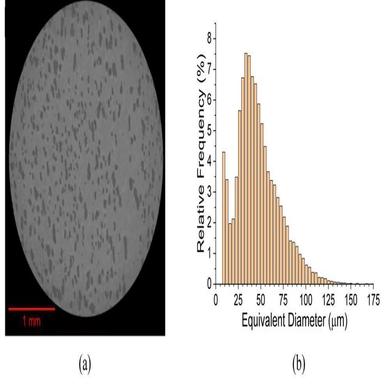
(a) X-CT image of FDE-AM sample (b) Relative frequency distribution as a function of equivalent diameter of void. EFD-AM samples contain a total of 15.5 volume % voids.